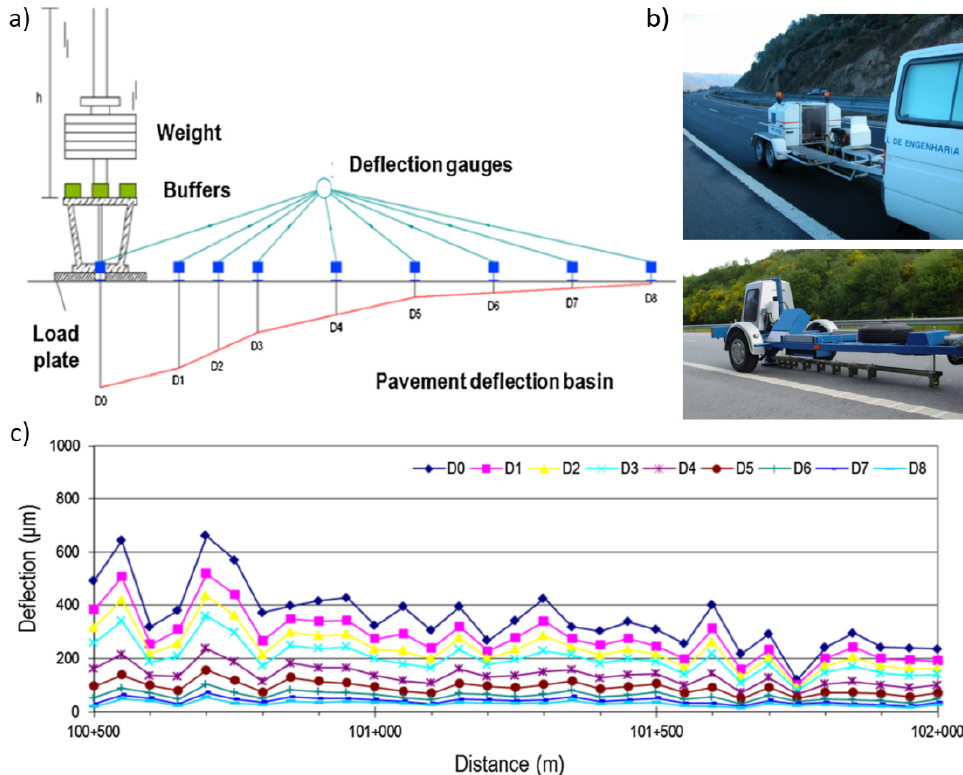
Figure 7. Falling Weight Deflectometer. ( a ) FWD scheme, ( b ) two different FWD devices, and ( c ) example of FWD measured deflections on a road section [136].